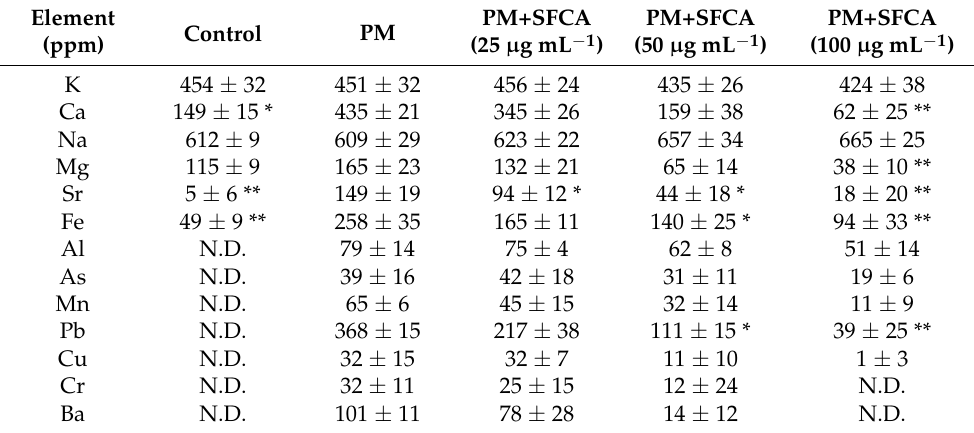
Table 2. Changes of elemental metal compositions in PM-induced keratinocytes with SFCA during 24